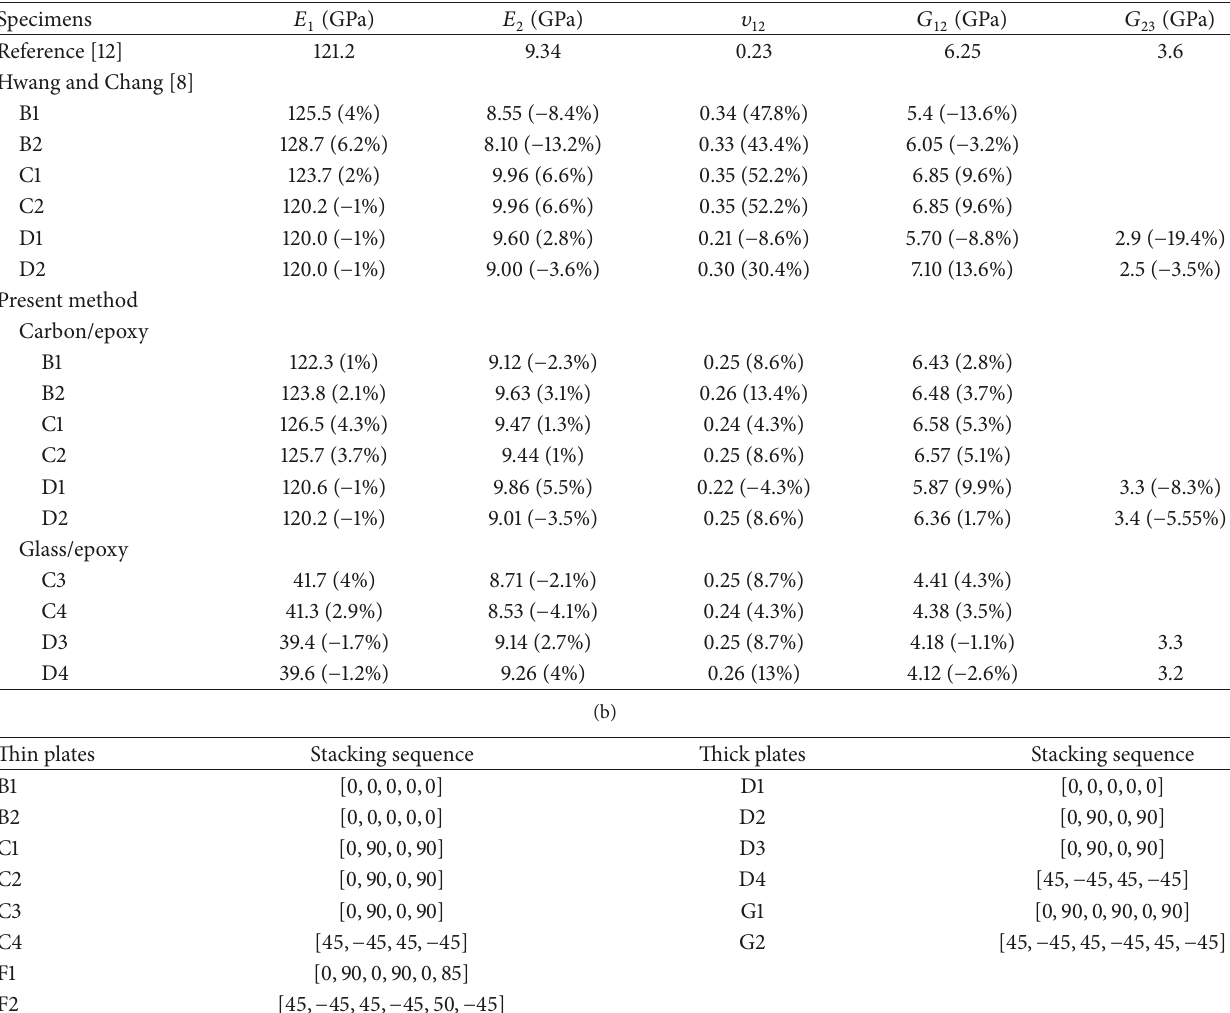
Table 9: Simultaneous determination of material constants and stacking sequence for composite